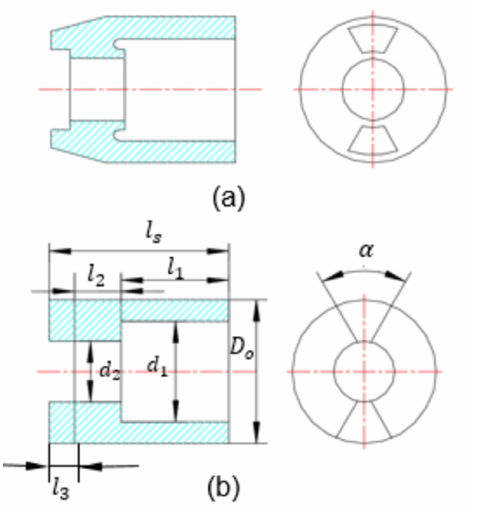
Figure 15. ( a ) Shock block shape ( b ) Simplified shock block